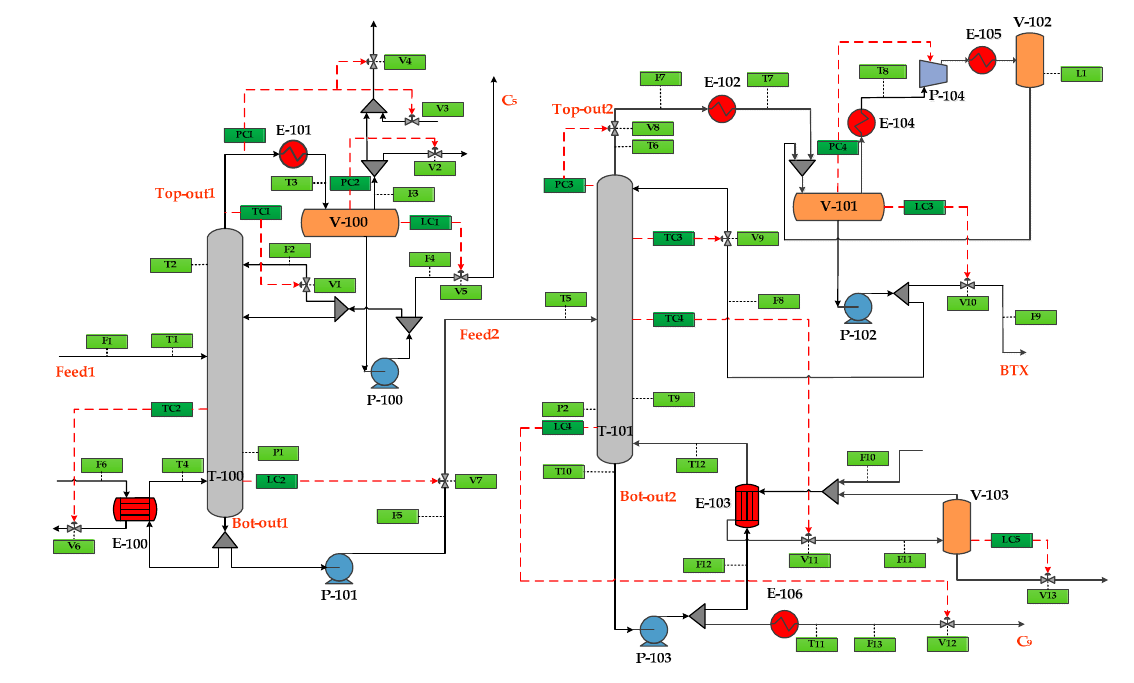
Figure 9. The flowsheet of dynamic simulation. Table 2. The main variables in a hydrogenation prefractionation system.